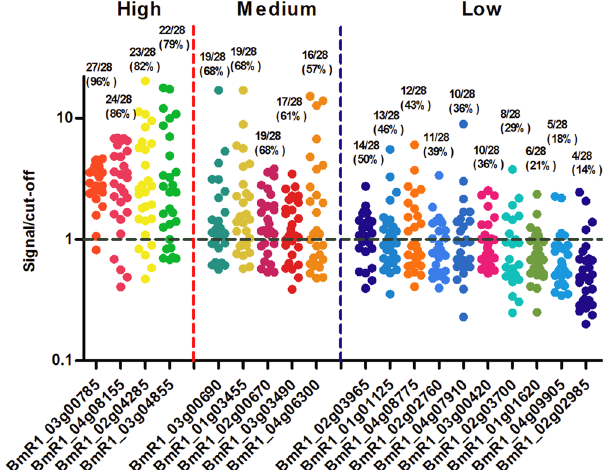
Figure 2. Reactivity of recombinant B. microti proteins against sera from B. microti -infected patients in BmELISA. Nineteen recombinant B. microti proteins were tested against 28 human sera positive for B. microti antibodies. Signal/cutoff is calculated by dividing the individual absorbance (A 450nm ) with the mean optical density reading for the human serum samples negative for antibodies to B. microti (n = 15) + 2 standard deviations of the mean. Circles represent the reactivity of each patient serum against individual recombinant protein. Immunoreactivity was classified as high, medium and low based on having the highest percentage of positives over the signal/cut-off value above 1.